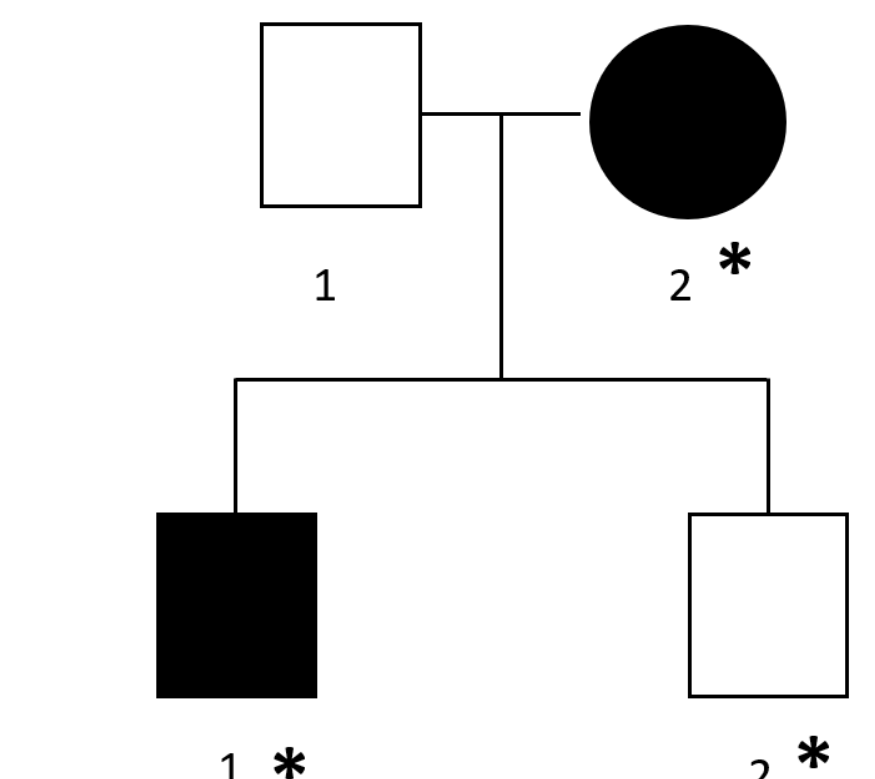
Figure 1. Pedigree of the family enrolled. The black symbols represent individuals with bilateral rotator cuff lesions. Asterisks stand for subjects who undergone Whole Exome Sequencing.